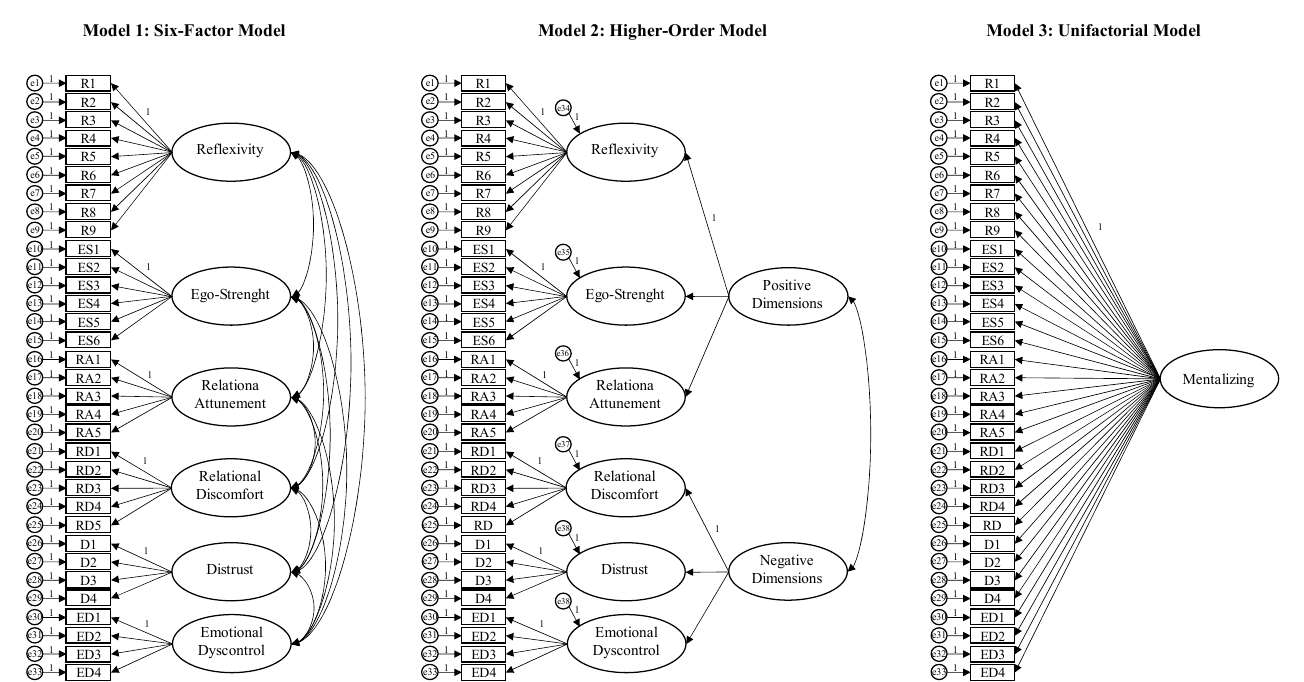
Figure 2. The tested factorial structure models for the MMQ.